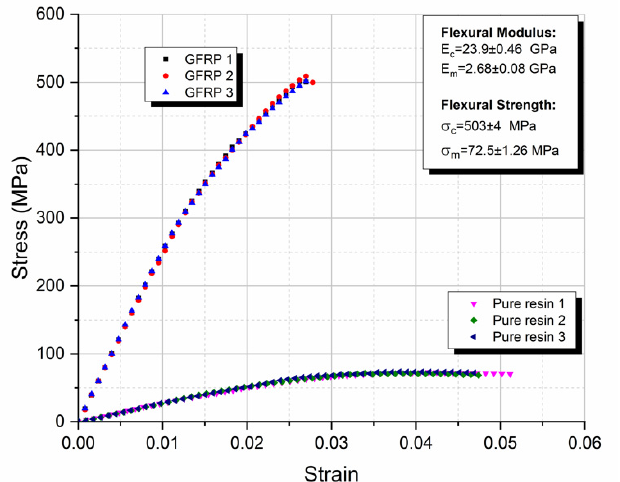
Figure 3. Three-point bending tests of the GFRP composites and the neat epoxy resin.